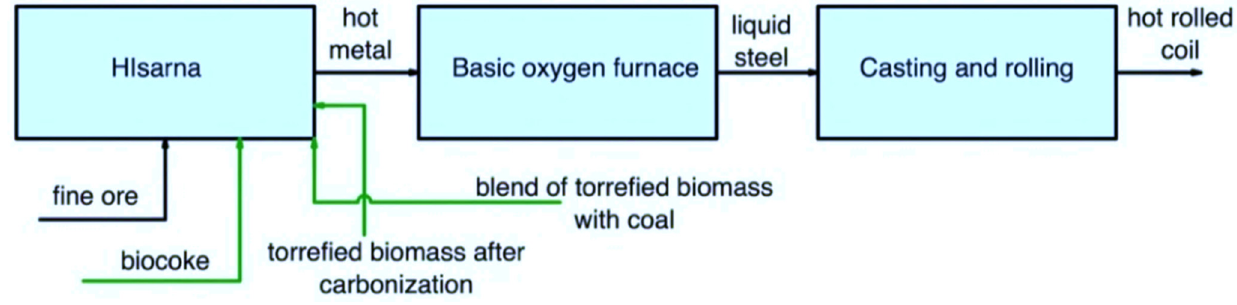
Figure 9. Main pathways for using secondary carbon bio-carriers in the HIsarna/BOF route.